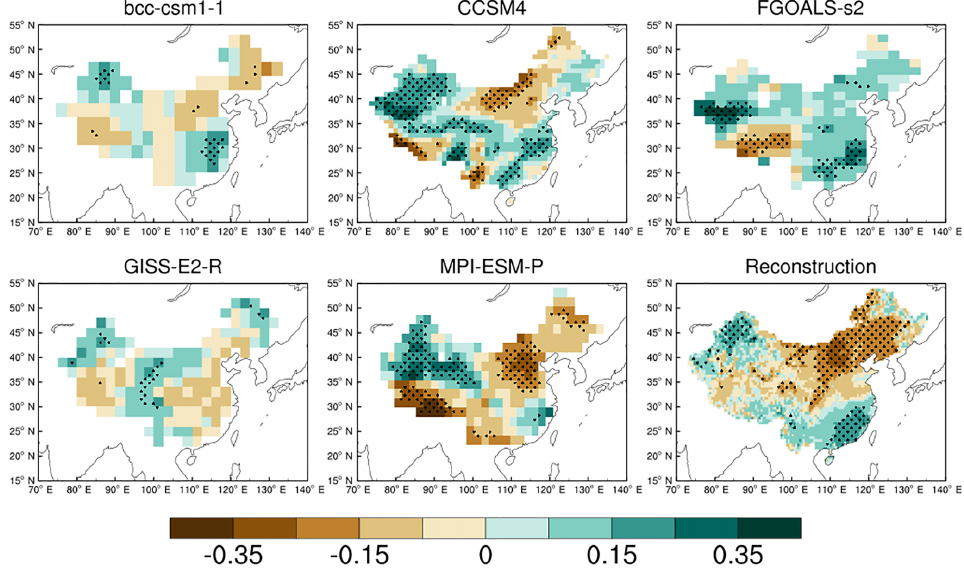
Figure 9. Correlation maps of five simulated and reconstructed MJJAS mean precipitation anomalies for China with the five corresponding simulated annual mean Niño 3.4 indices and a reconstructed annual mean ENSO index (McGregor et al.,